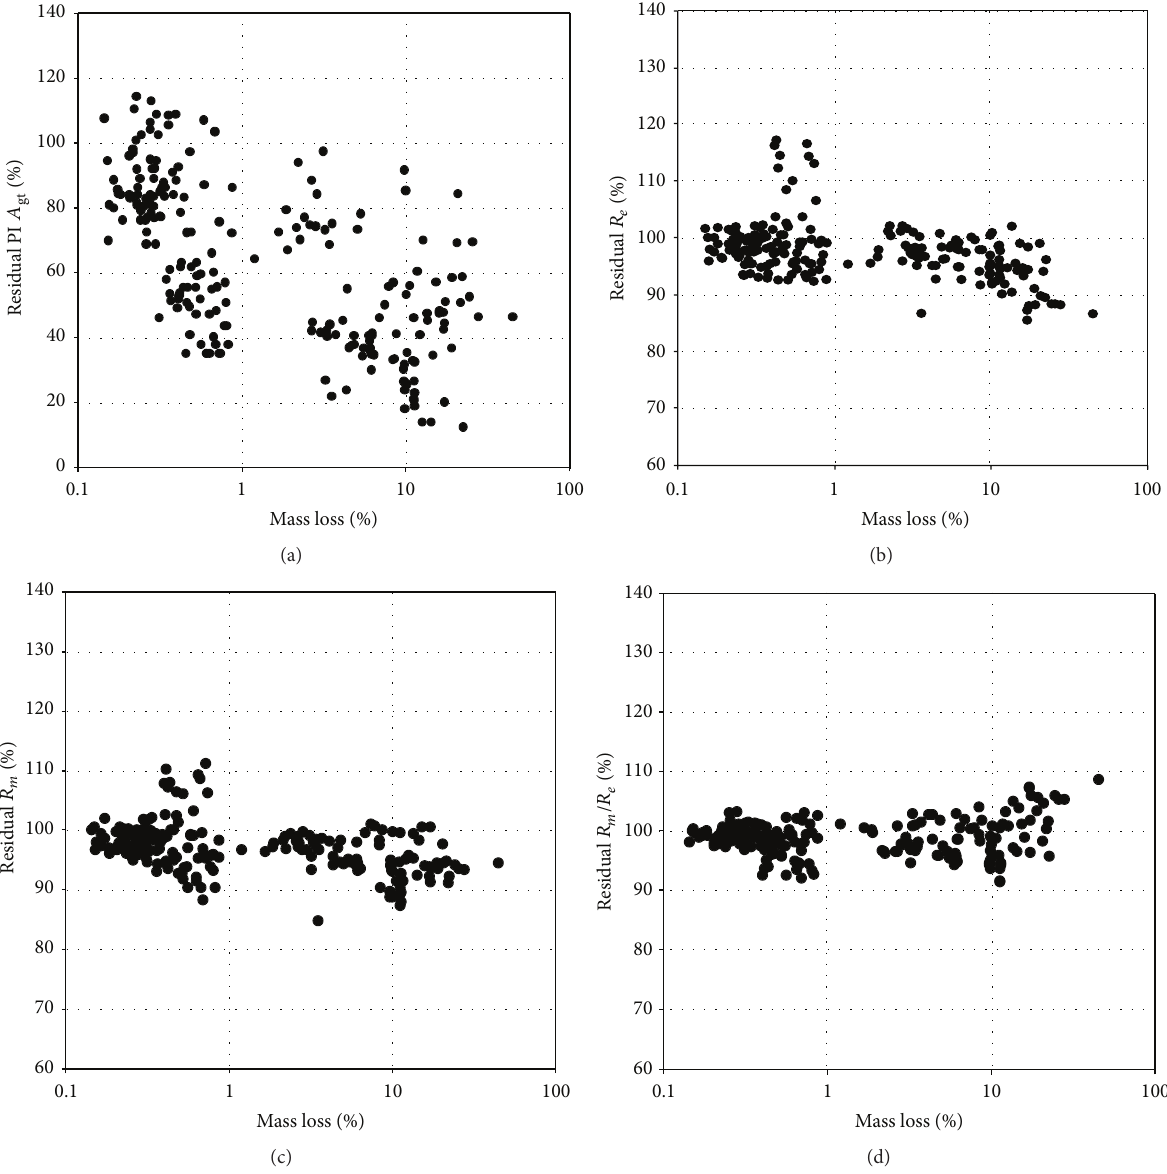
Figure 12: Representation of the trend of (a) residual elongation at maximum load ( 𝐴 tensile strength ( 𝑅 𝑚 ), and (d) residual hardening ratio ( 𝑅 𝑚 /𝑅 𝑒 ) towards obtained values of mass